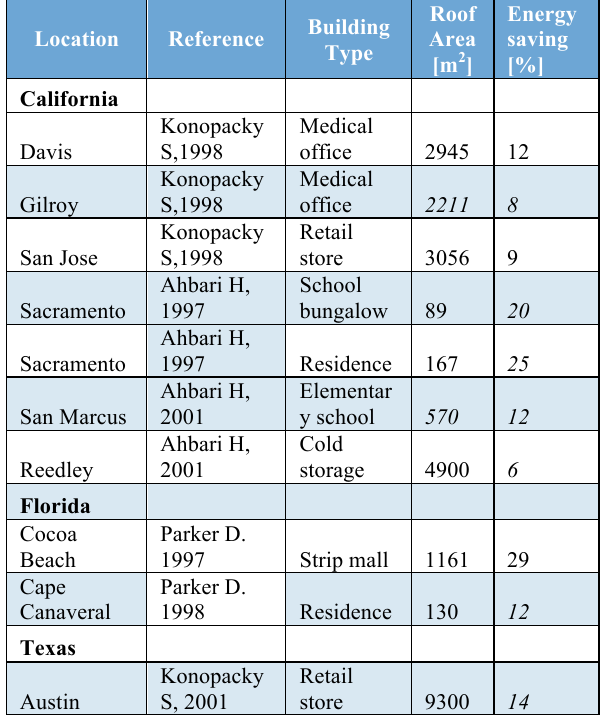
Tab. 1. Summary of performance of cool roofs based on field studies for US buildings (Testa, 2017).